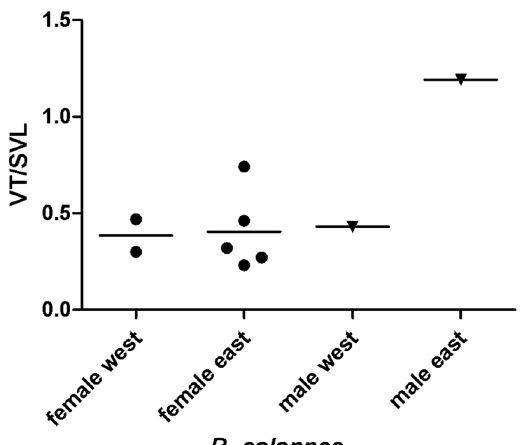
Figure 3. Bolitoglossa colonnea Vertical scatter plot of vomerine teeth/snout-vent-length ratio for . Males and females from eastern and western localities are shown separately. Horizontal bars indicate mean values.